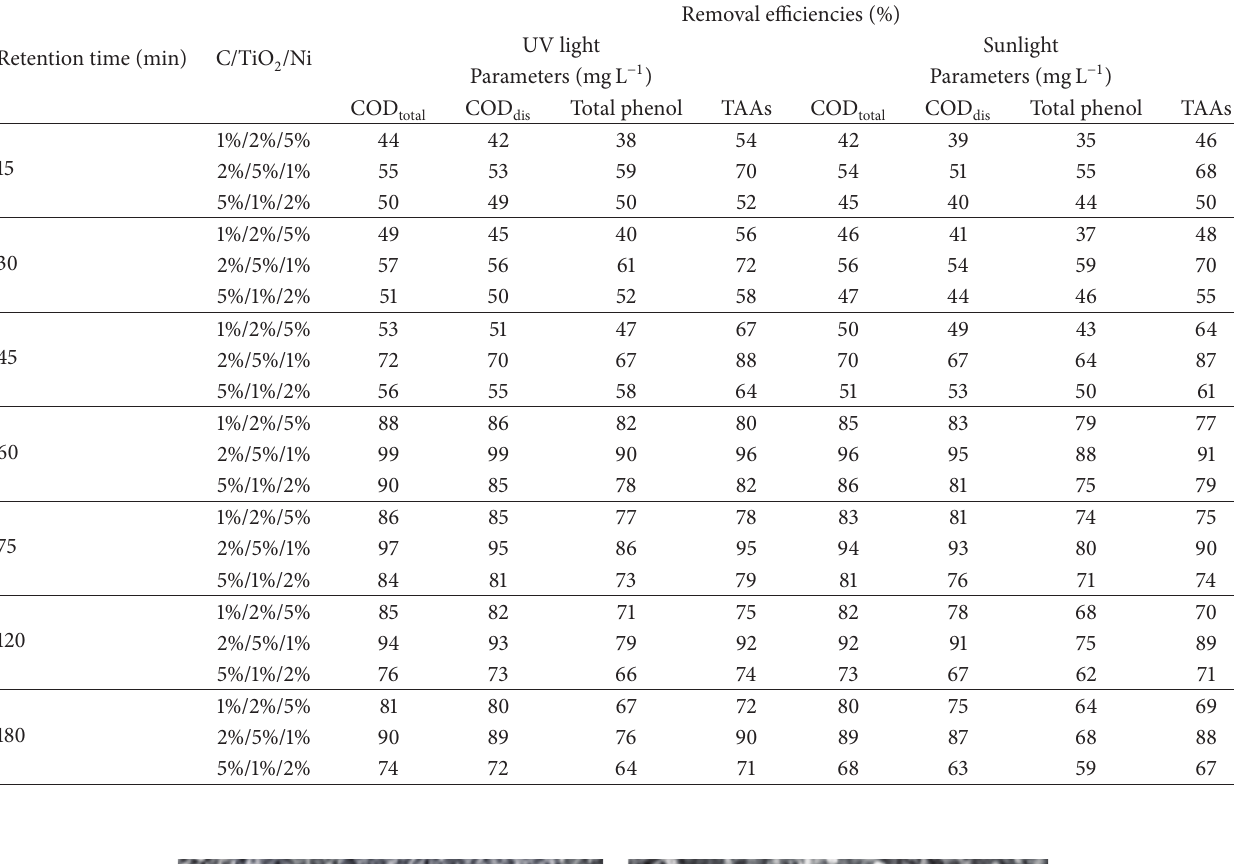
Table 2: Effect of mass ratios of C/TiO /Ni nanocomposites (1%/2%/5%, 5%/1%/2%, and 2%/5%/1%) and increasing retention times on the 2 /Ni nanocomposite, under 300 W UV and 30W sunlights, at pH removals of OMW during photocatalytic degradation, at 500 mg L − 1 C/TiO 2 = 7.0, and at 25 ∘ C ( 𝑛 = 3, mean values).